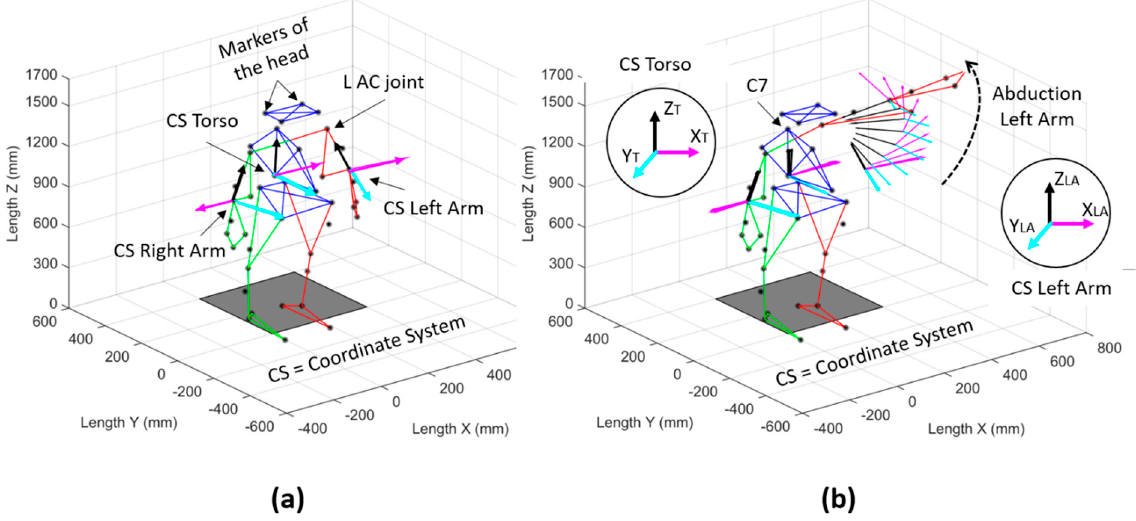
Figure 2. Three orthogonal coordinate systems were created to measure the kinematics of the glenohumeral joint of the affected side: ( a ) isometric view of the reconstructed markers of the participant; ( b ) abduction movement of the left arm. CS, coordinate system; L AC joint, left acromioclavicular joint; C7, 7th cervical vertebra.